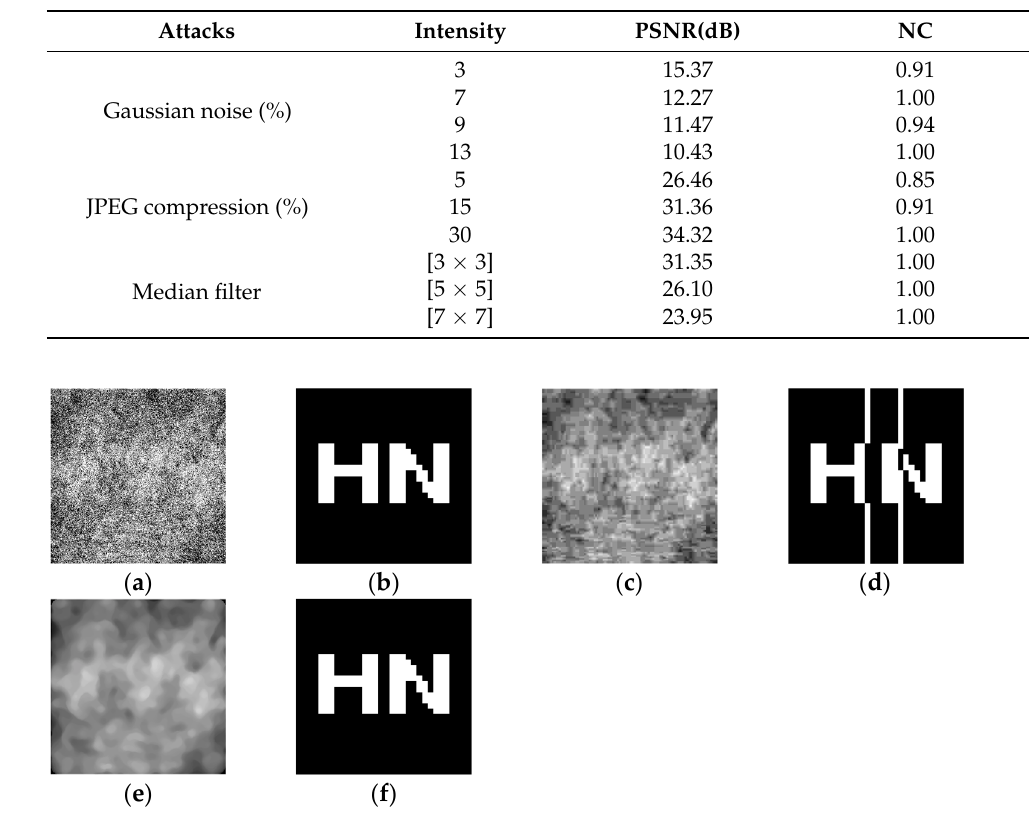
Figure 13. Encrypted medical images and extracted watermarks after some conventional attacks. Images after 13% attack of Gaussian noise and corresponding extracted watermarks ( a , b ), images after 5% attack of JPEG compression and corresponding extracted watermarks ( c , d ), and images after 10 attacks of median filtering [7 × 7] and corresponding extracted watermarks ( e , f ). Table 3. Experimental data under conventional attack.